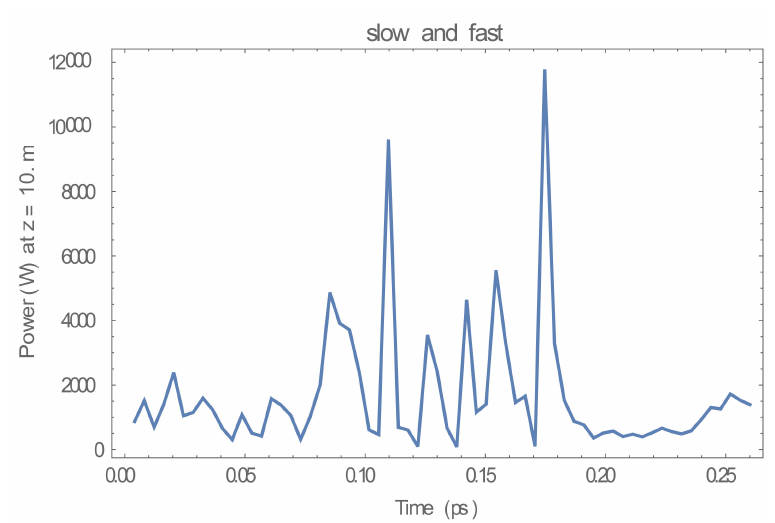
Figure 9. The temporal pulse shape at z = 10.0 m for the sum of the fundamental and the higher-order modes of h = 1, 3, and 5 modes in the two-beam system with the elliptically polarized undulator (color online).